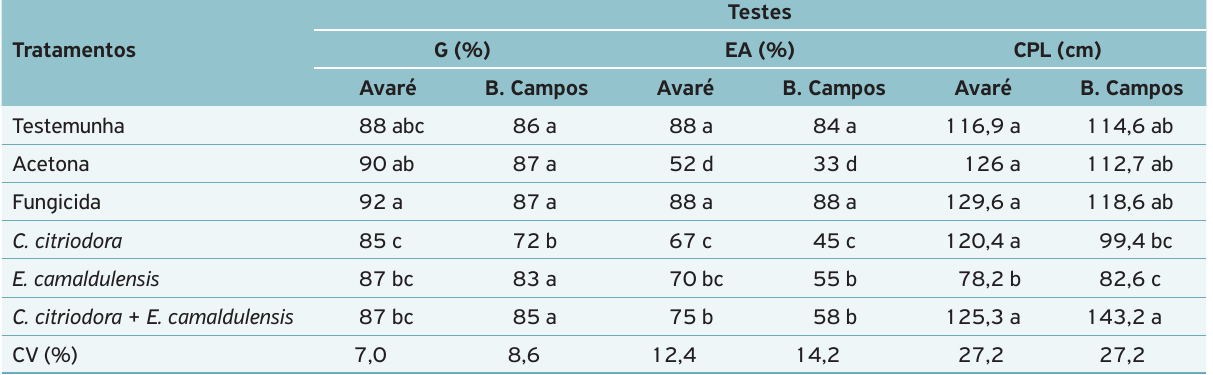
Tabela 2. Testes de germinação, envelhecimento acelerado e comprimento de plântulas de amostras de sementes provenientes